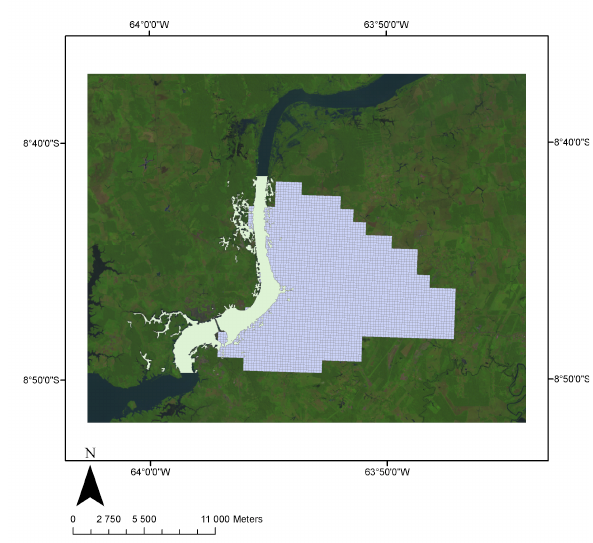
Figure 3: Flooded area classification from Landsat image of 08/04/2014 overlapping census gridded data from